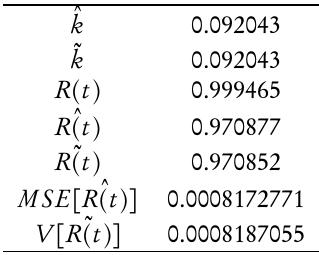
Estimates of k and R(t), variance and MSE under type I